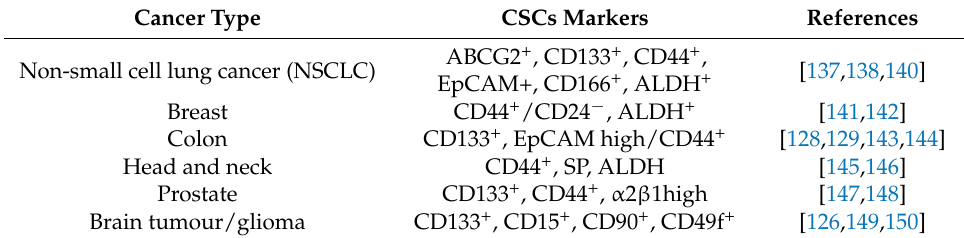
Table 2. CSCs markers from different tumour types. ALDH—aldehyde dehydrogenase;